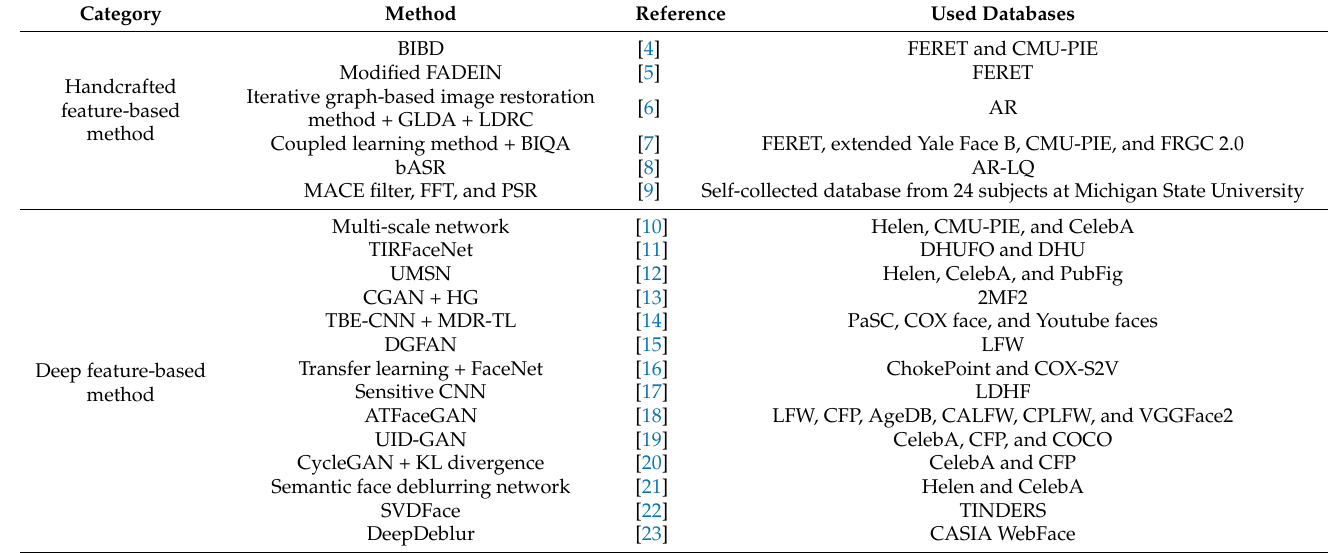
Table 1. Studies on face recognition robust to image blurring. All the methods used open